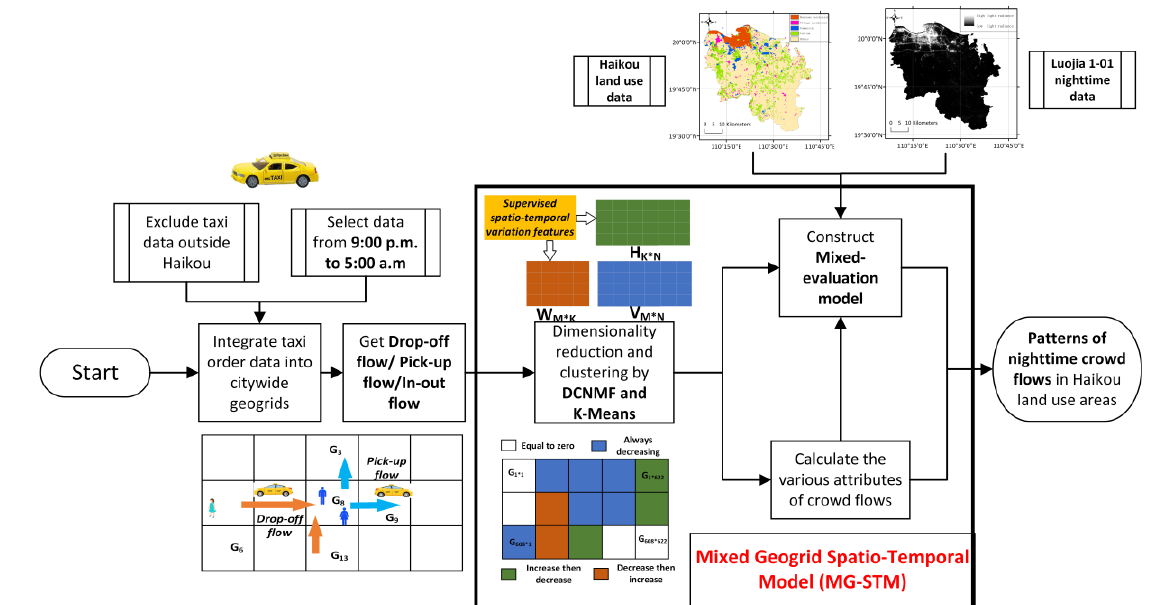
Figure 1. Research flowchart of patterns of nighttime crowd flows in Haikou based on taxi data.